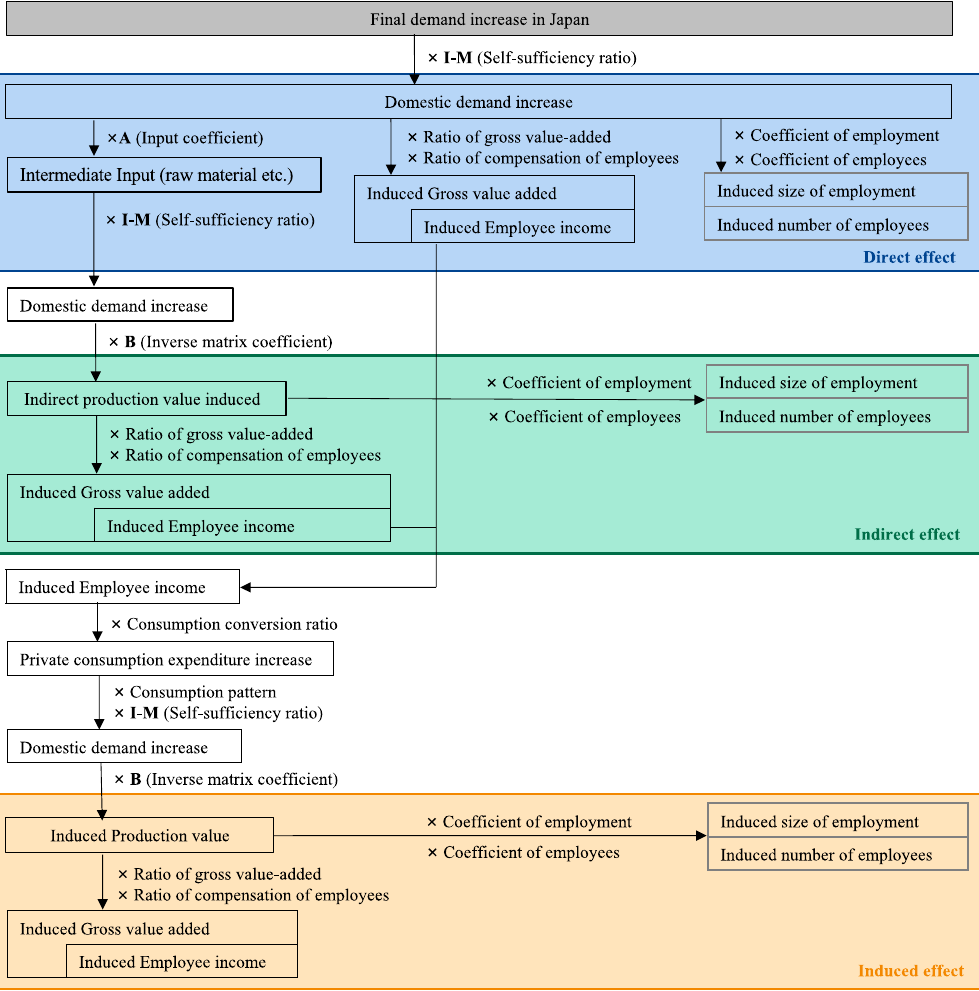
Figure 4. The flowchart of the economic ripple effect calculation.